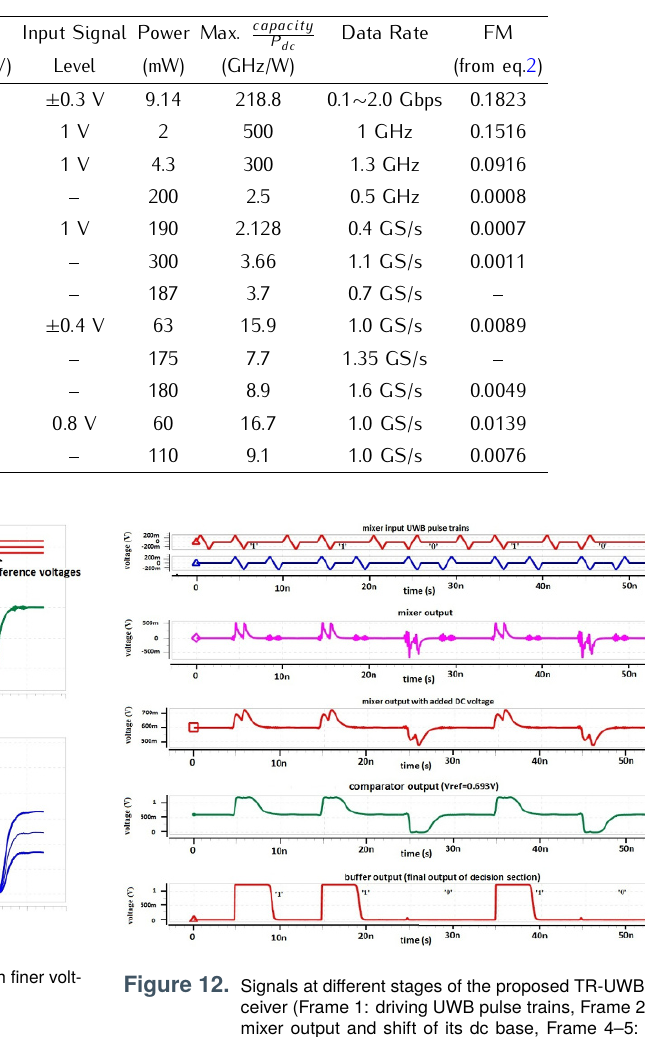
Table 1. Comparison of the proposed design with reported decision circuits.